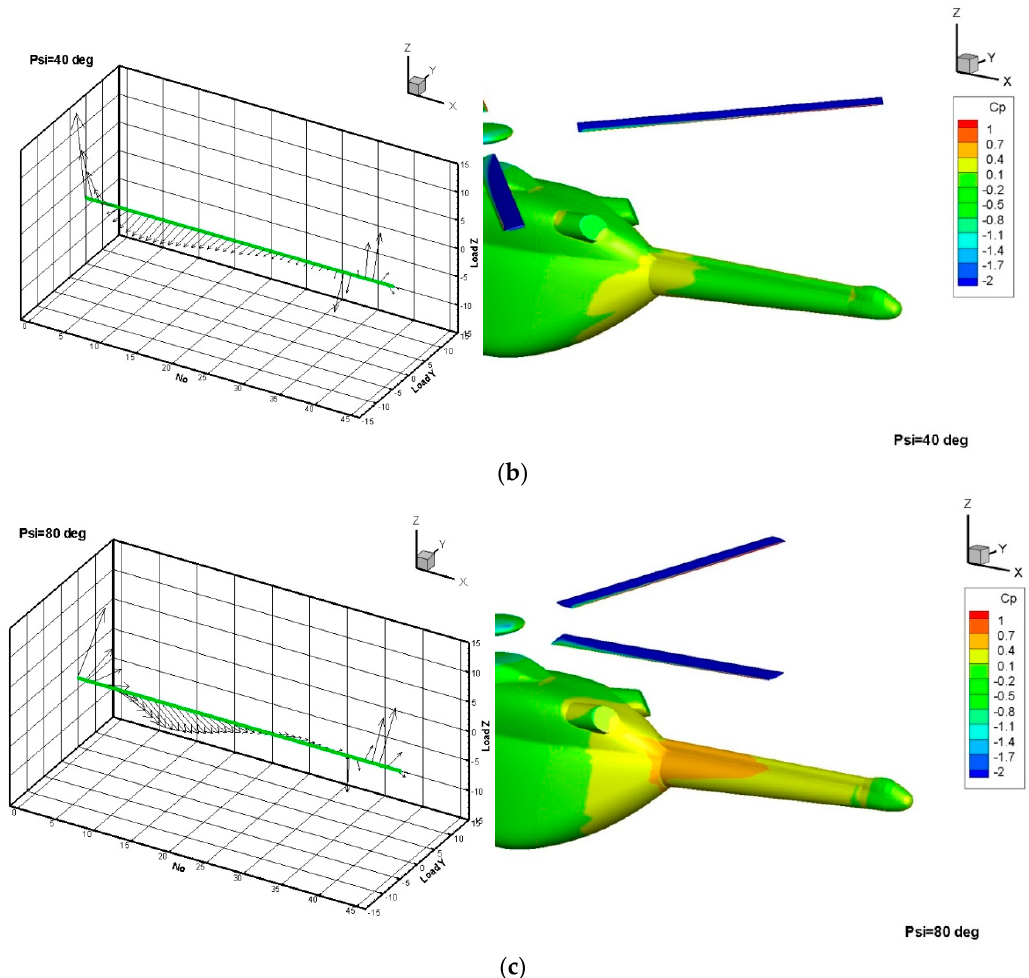
Figure 10. Load Z and Load Y present sectional forces along the tail boom projected in the vertical (Z) and lateral directions for different azimuthal positions: ( a ) ψ = 0 ◦ , ( b ) ψ = 40 ◦ , ( c ) ψ = 80 ◦ .